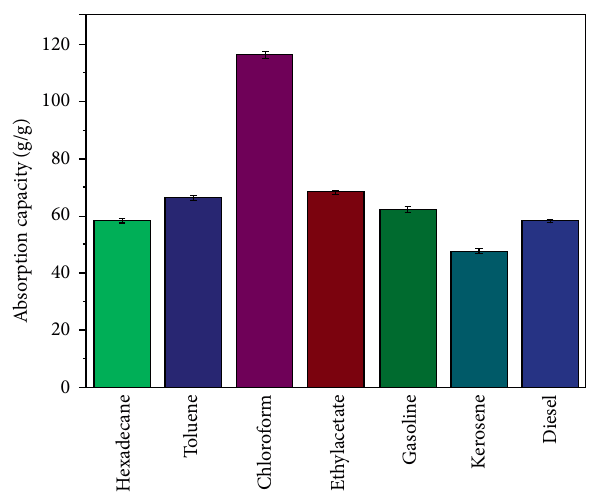
Figure 7: Absorption capacities of the PDMS-SP sponge for different organic solvents and